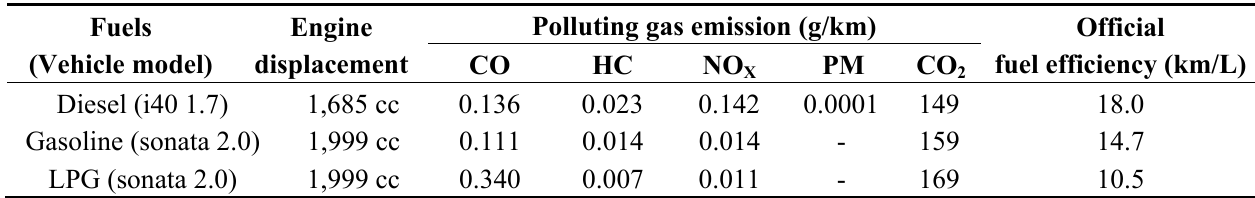
Table 1. Polluting gas emission of diesel, gasoline and LPG.